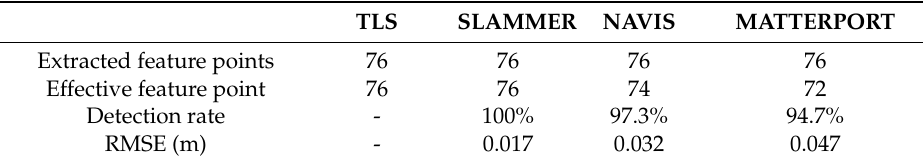
Table 8. Accuracy assessment results for feature points selected by